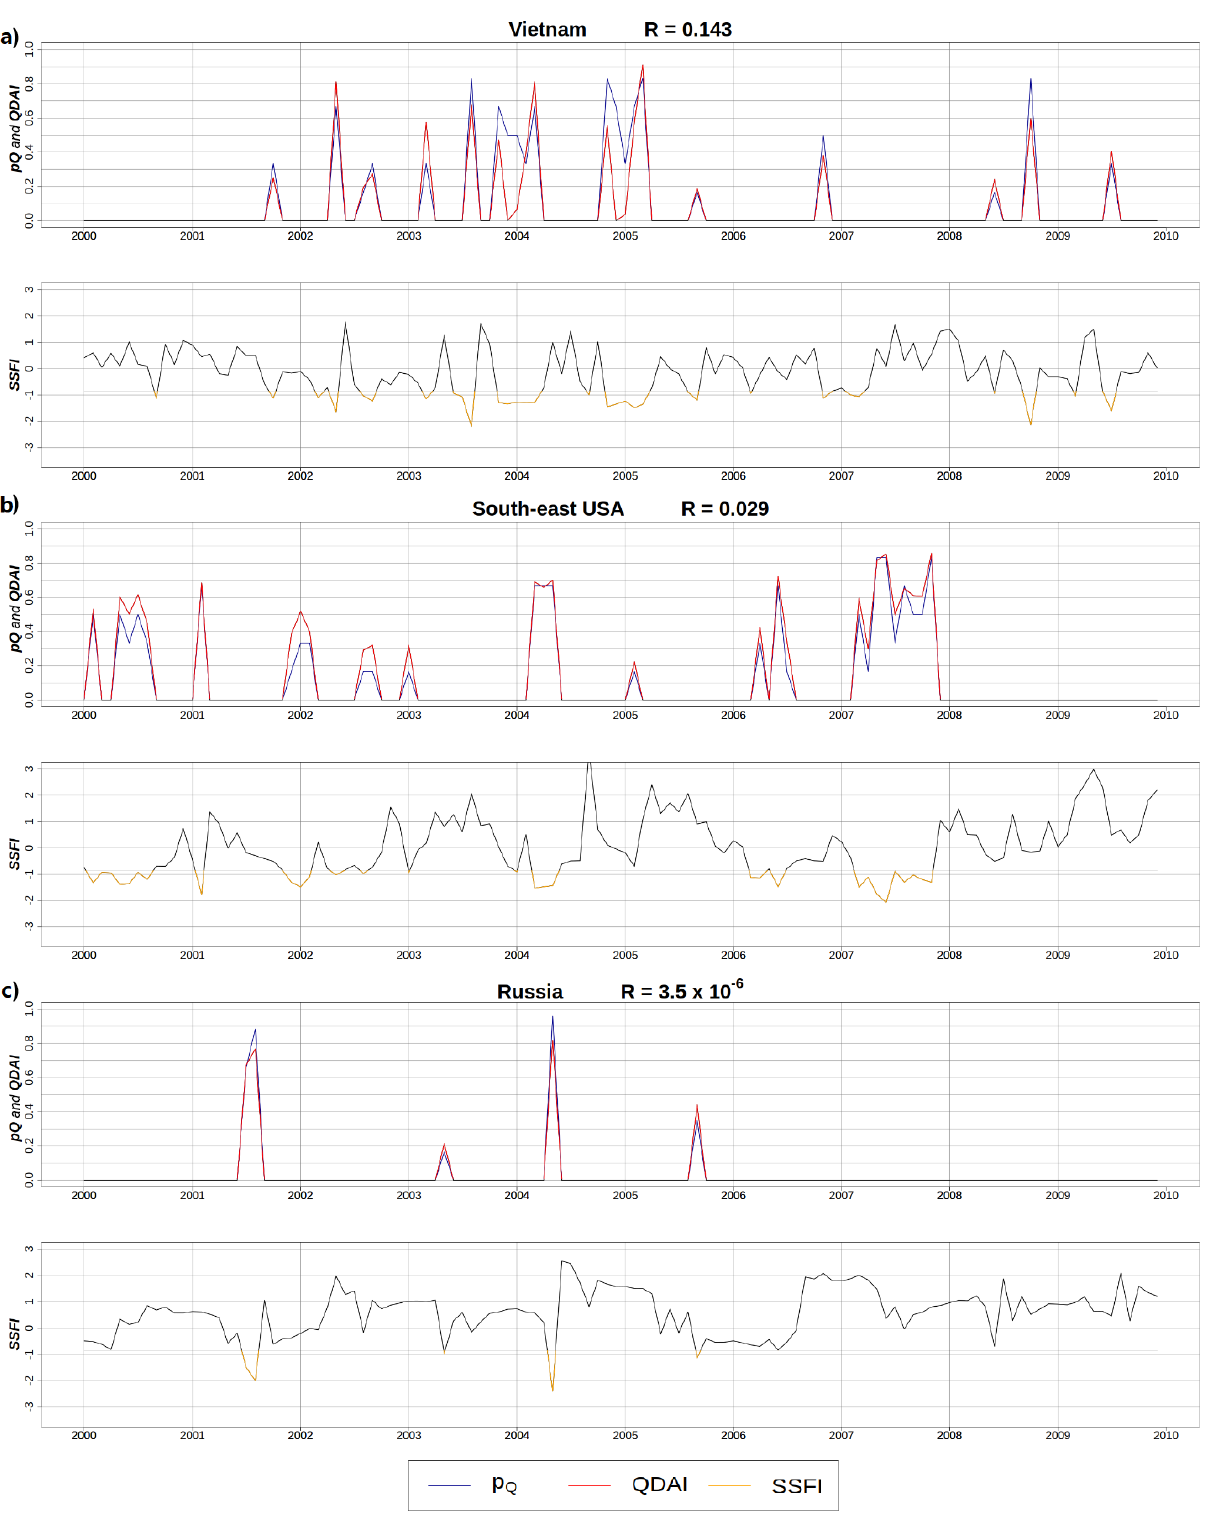
Figure 10. Time series of QDAI and SSFI for grid cells with different ratios of surface water abstractions to streamflow R in three regions: it is below − 0.84 standard deviations, corresponding to a 5-year return period and a p of zero (Table